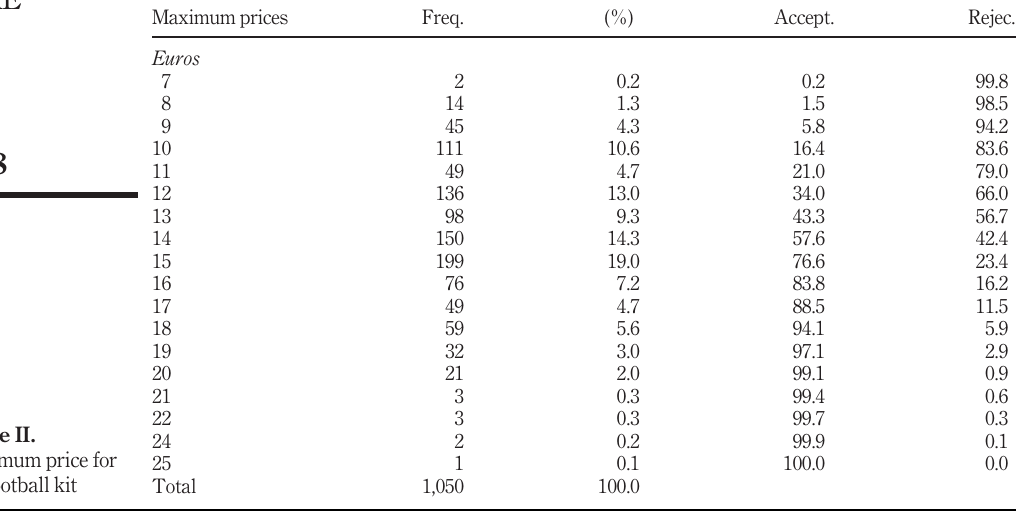
calculations comparing the interviewees ’ fi gures of minimum and maximum prices